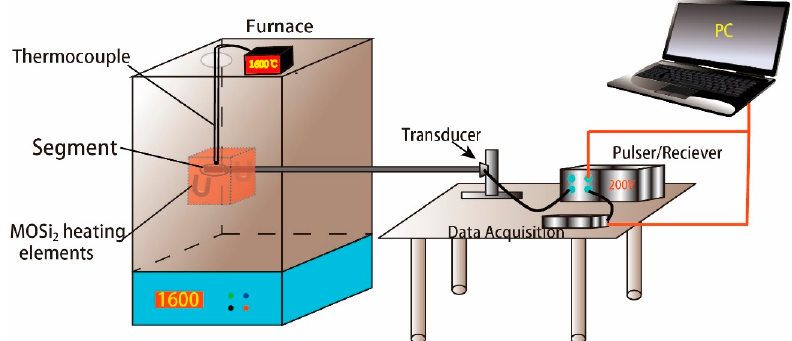
Figure 5. Schematic diagram of the test setup.